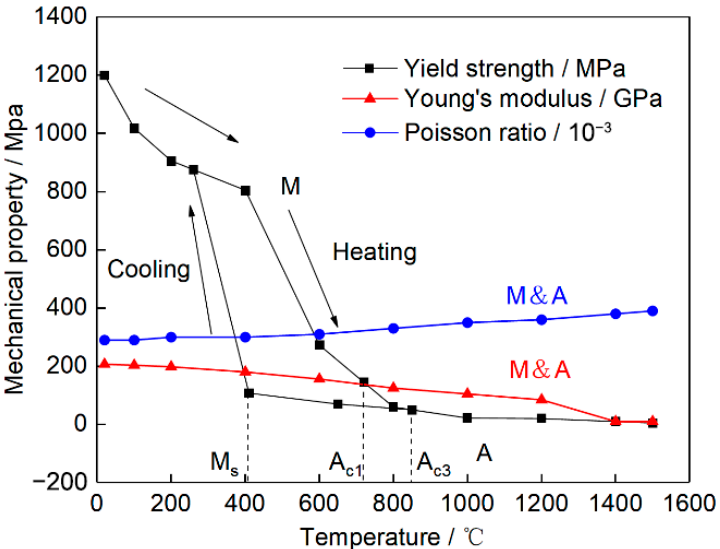
Figure 10. Mechanical properties of NM450TP wear-resistant steel.